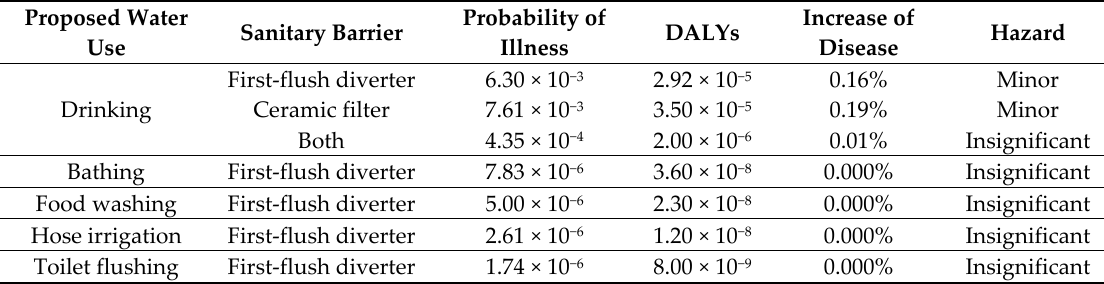
Table 8. Median values of annual risk considering the adoption of sanitary